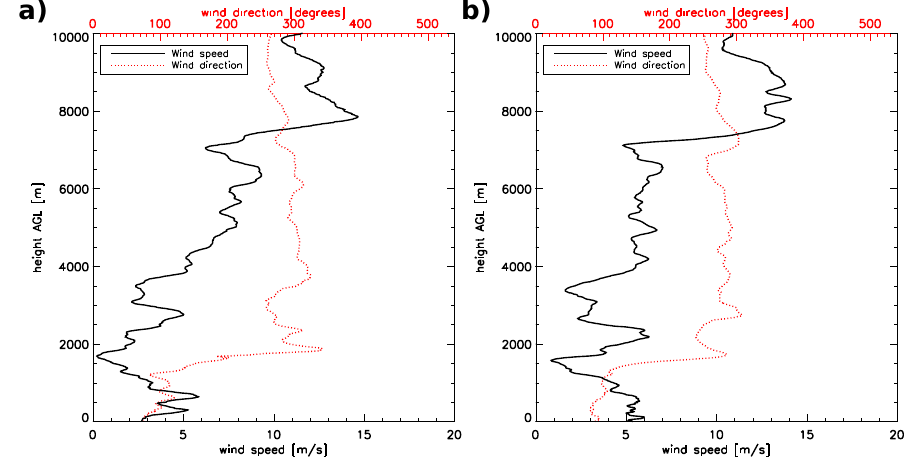
Figure 3. Wind profiles (speed and direction) of the lowest 10km of the atmosphere measured by the radiosondes at 25 June 2011: (a) 10:34UTC and (b) 16:44UTC.